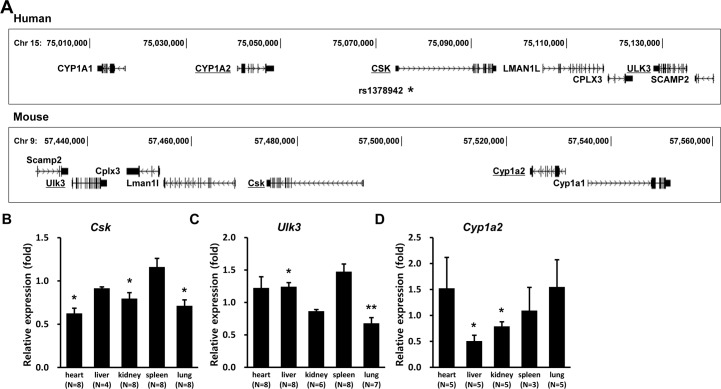
Location of candidate genes in the 15q24 GWAS locus and reduction of target gene mRNAs in siRNA-injected mice.(A) Positions of candidate genes are comparably shown on the human 15q24 locus and on the homologous mouse chromosome 9, 31.18 cM in the opposite direction; * indicates position of rs1378942, the lead SNP for blood pressure GWASs in the 15q24 locus. (B) The relative expression of candidate gene mRNAs in each tissue is presented as the fold change of relative mRNA levels in candidate gene versus control siRNA-injected mice after 1-time siRNA injection. Error bars show the mean ± SEM. Number in parentheses indicates the pair number of mice used for real-time PCR analysis. P values were calculated by Mann-Whitney U-test. * P<0.05 versus respective controls.